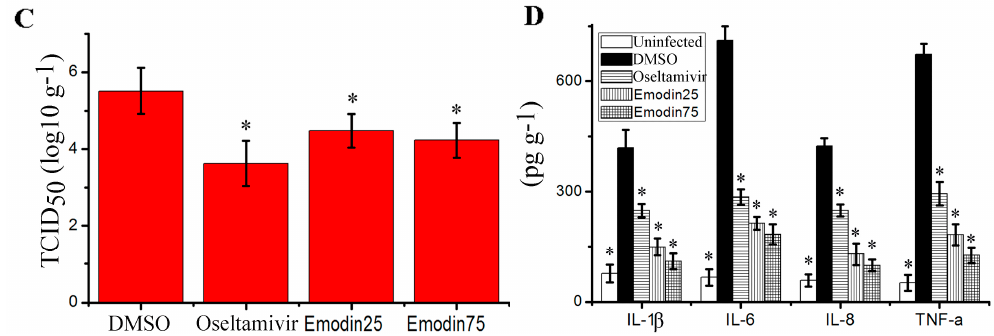
Figure 6. Influence of emodin on the survival rates, lung index, pulmonary viral titer and lung cytokines in mice infected with IAV (PR8). In the uninfected control (Uninfected), mice were not infected with IAV (PR8) and treated with DMSO (0.5%) by oral gavage. In the negative control (DMSO), positive drug control (Oseltamivir) and emodin-treated groups (Emodin25 and Emodin75), mice were intranasally infected with 10× MLD 50 of IAV viruses in a 50 μ L volumes, and treated with DMSO (0.5%, v / v ), oseltamivir (10 mg kg − 1 day − 1 ) and emodin (25 mg kg − 1 day − 1 and 75 mg kg − 1 day − 1 ) by oral gavage from day − 1 to day 5 p.i. ( A ) The survival rates were observed for 14 days ( n = 10); ( B ) The lung index was evaluated by determining the percent of lung wet weight (g) to body weight (g) (lung index = lung wet weight (g) ÷ body weight (g) × 100%) at day 6 p.i. (n = 6); ( C , D ) Pulmonary viral titer and lung cytokine were determined by TCID 50 and ELISA assays, respectively, at day 6 p.i. ( n = 6). Data shown were mean ± SD. * p < 0.05 vs. the DMSO control. Chi-square ( χ 2 ) test was performed for A. One-way ANOVA with post hoc Dunnett’s test was performed for B , C and D .